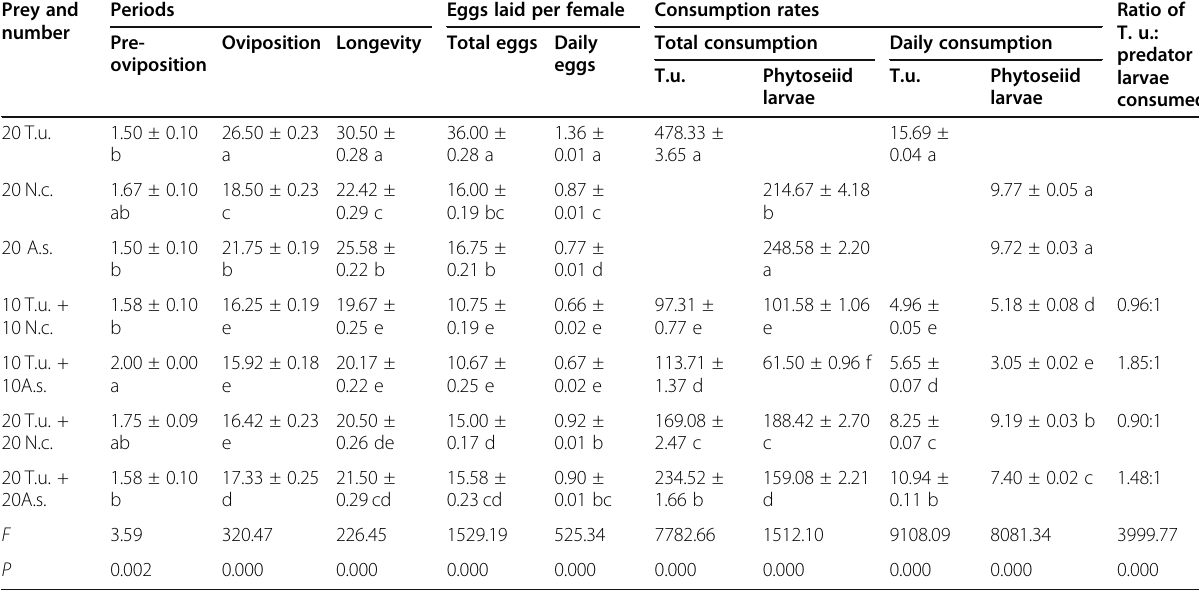
Table 2 Mean (± SE) pre-oviposition, oviposition periods and longevity, mean number (± SE) of total and daily eggs laid per female, total and daily number (± SE) of prey consumed per female for Neoseiulus barkeri fed solely on Tetranychus urticae (T.u.) or larval Neoseiulus californicus (N.c.), Amblyseius swirskii (A.S.) or on a combination of T. urticae , and larval phytoseiid Prey and Periods Eggs laid per female Consumption rates Ratio of number T. u.: T.u.